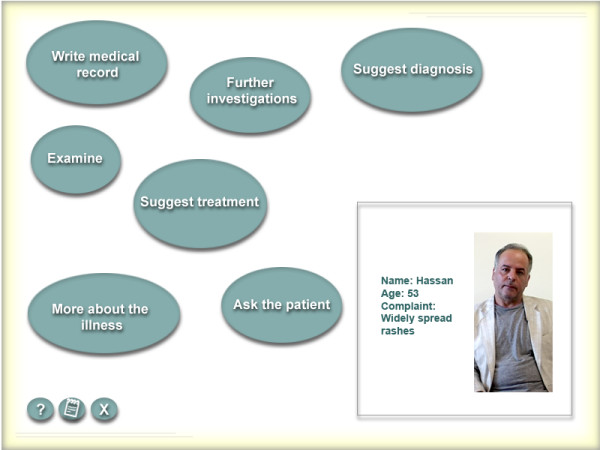
User's options (menu) for the management of a patient. The text is in Swedish in the program.